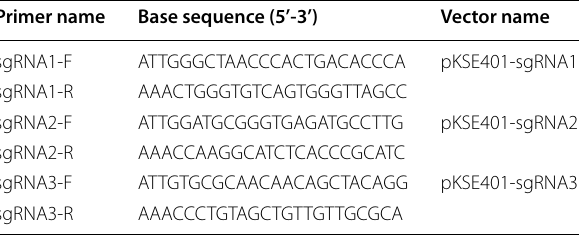
Table 1 The primers used for different vectors construction